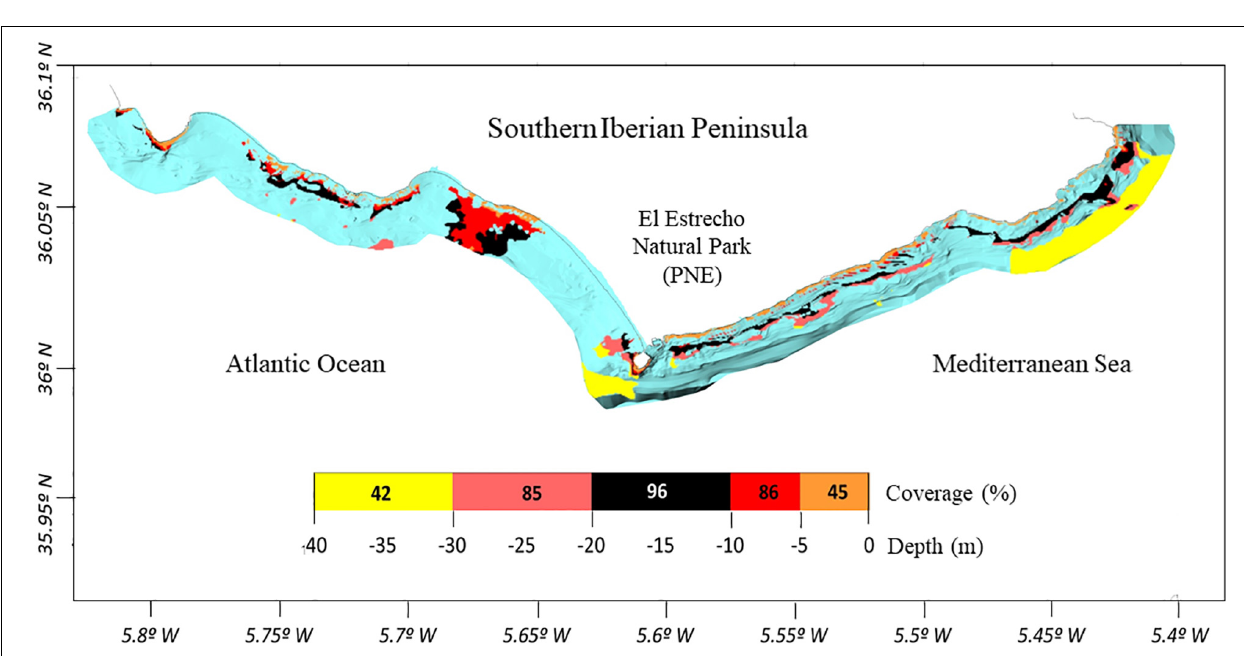
FIGURE 5 | Distribution map of estimated R. okamurae coverage along the rocky coastline of the PNE. Color scale represents coverage percentages per bathymetric intervals. Blue colors are referred to the total area considered within the cartography (i.e., 1 mile from the